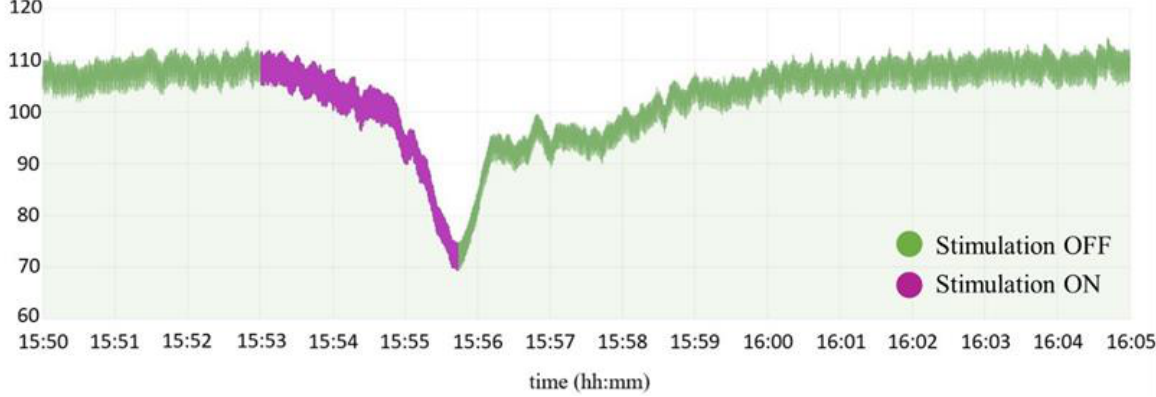
Figure 5. Mean arterial pressure change during the stimulation period intraoperatively marked in purple.